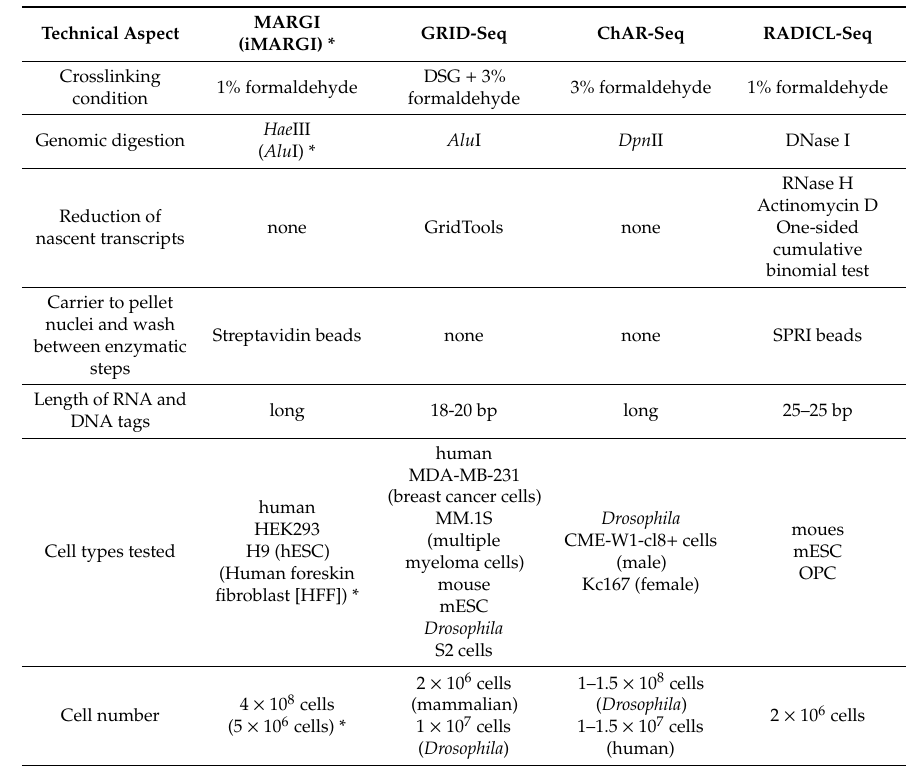
Table 1. Comparison of conditions for MARGI, GRID-seq, ChAR-seq, and